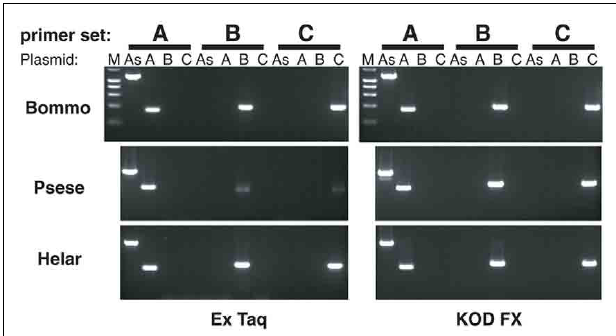
FIGURE 8 |Amplification of PBANR variants using species- and variant-specific primers. Amplification efficiencies of the primers were determined using plasmids containing the full-length sequence of each PBANR variant (PBANR-As -A, -B, or -C). Specific primer sets used are listed in Table 1 . Amplification was performed for 30 cycles using either a conventional polymerase (ExTaq) or a GC-optimized polymerase (KOD-FX). Species abbreviations are per National Center for Biotechnology Information/Swiss Prot: Bommo, B. mori ; Psese, P. separata , and Helar, H. armigera .